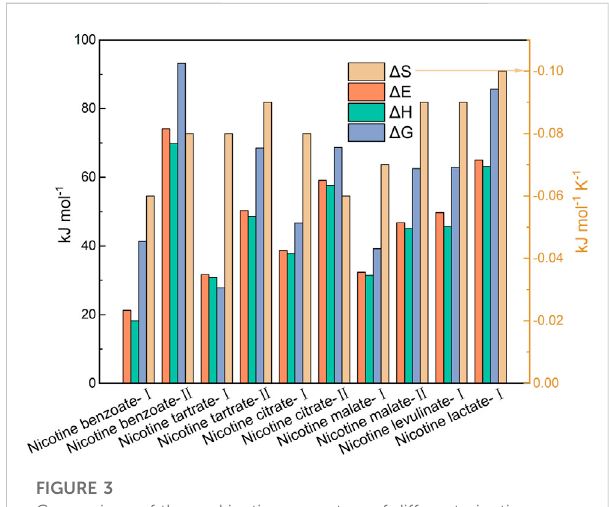
FIGURE 3 Comparison of thermokinetic parameters of different nicotine salts in the main thermal decomposition